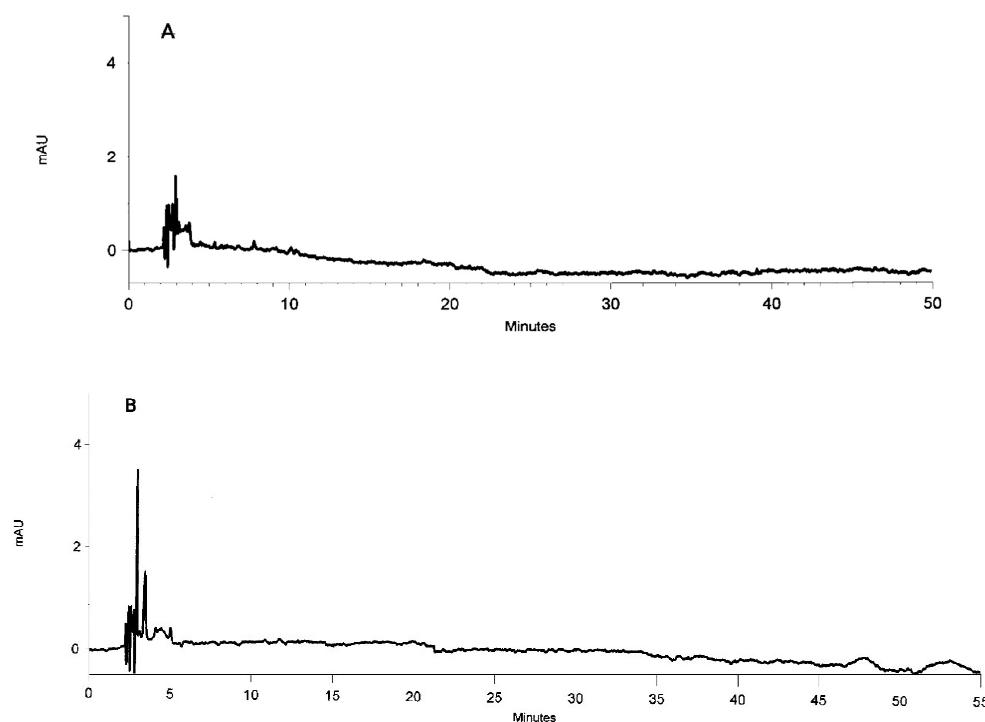
Figure 1. Chromatograms of the 4,4′-azobis(4-cyanopentanoic acid) (ACVA) control samples after incubation for 48 h at 60 °C recorded at: ( A )—295 nm, ( B )—280 nm.